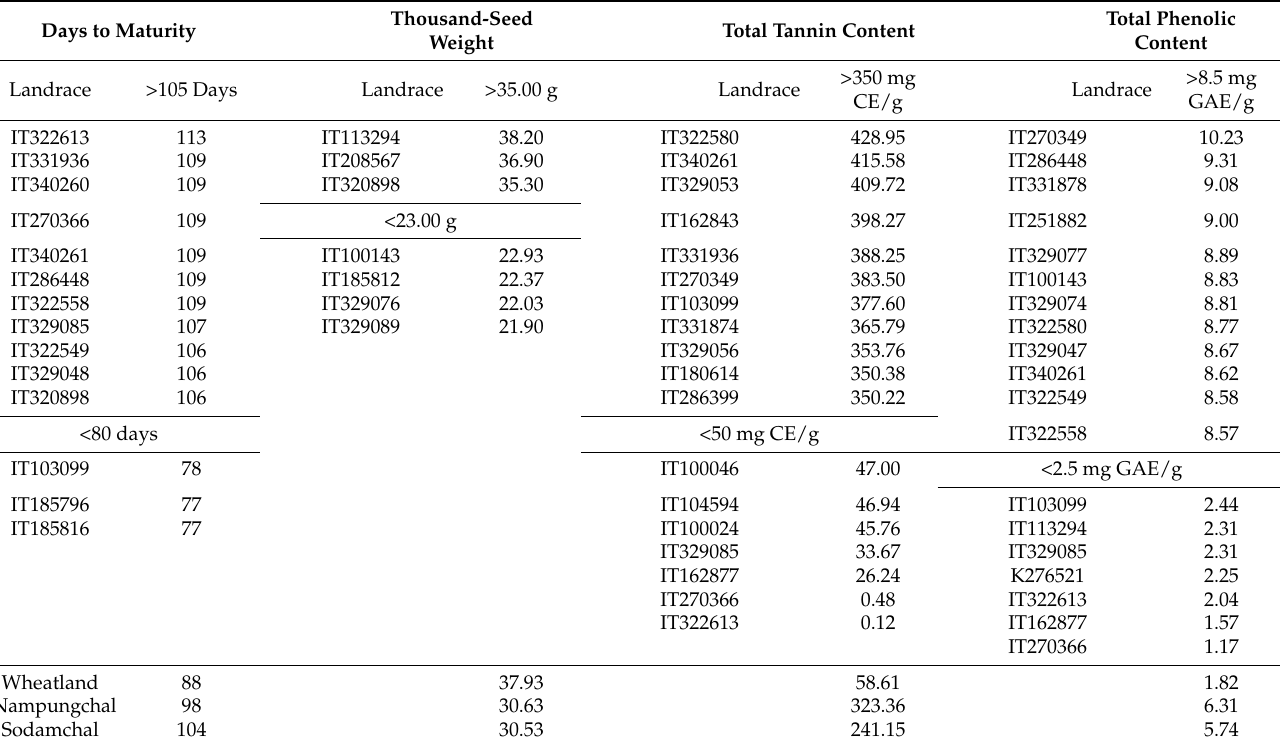
Table 3. Selected unique sorghum landraces with low and high DM, TSW, TTC and TPC